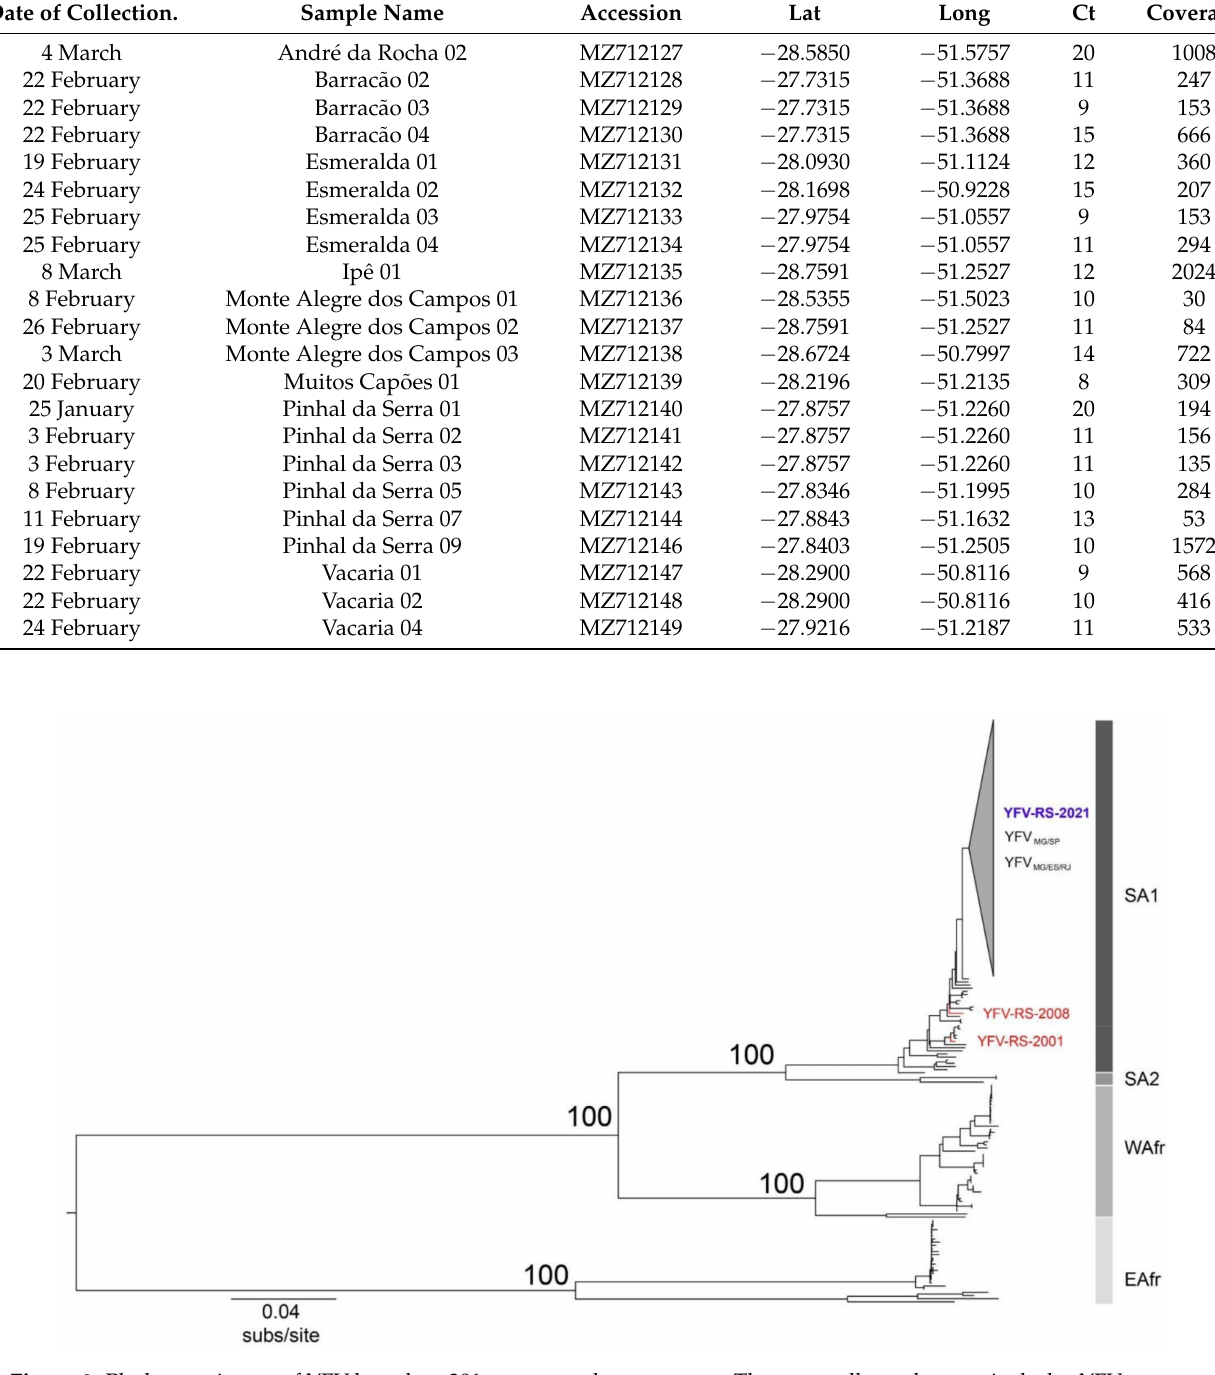
Figure 2. Phylogenetic tree of YFV based on 381 near-complete genomes. The gray collapsed group includes YFV MG/ES/RJ and YFV MG/SP clades and all genomes from RS sequenced in this study. South America I, South America 2, West Africa, and East Africa genotypes are indicated. Genomes recovered from previous epizootics in RS named YFV-RS-2001 (JF912189) and YFV-RS-2008 (KY861728) are highlighted in